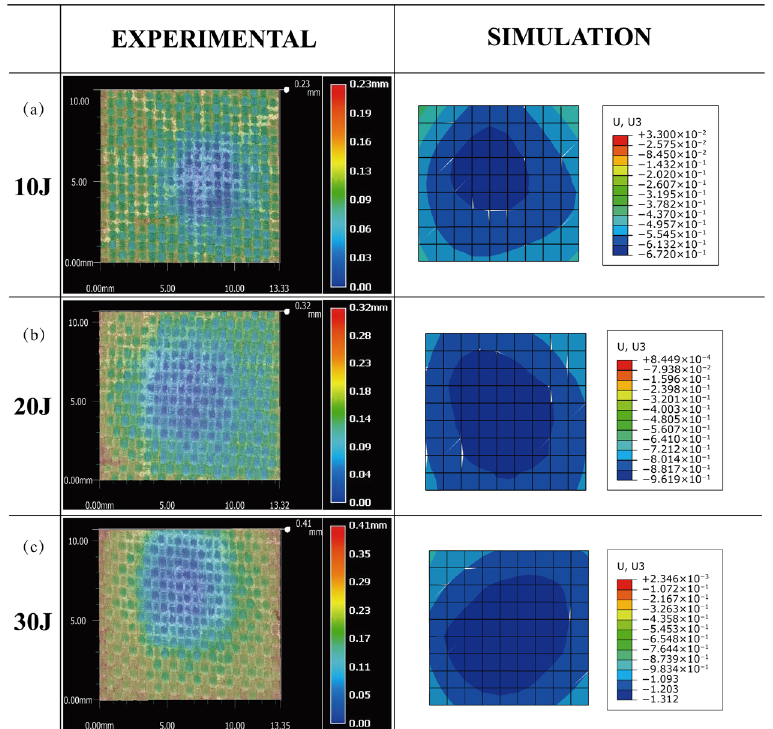
Figure 7. Comparison of the maximum deformation between the experiment and simulation of the honeycomb sandwich panel. ( a ) 10 J, ( b ) 20 J and ( c ) 30 J.